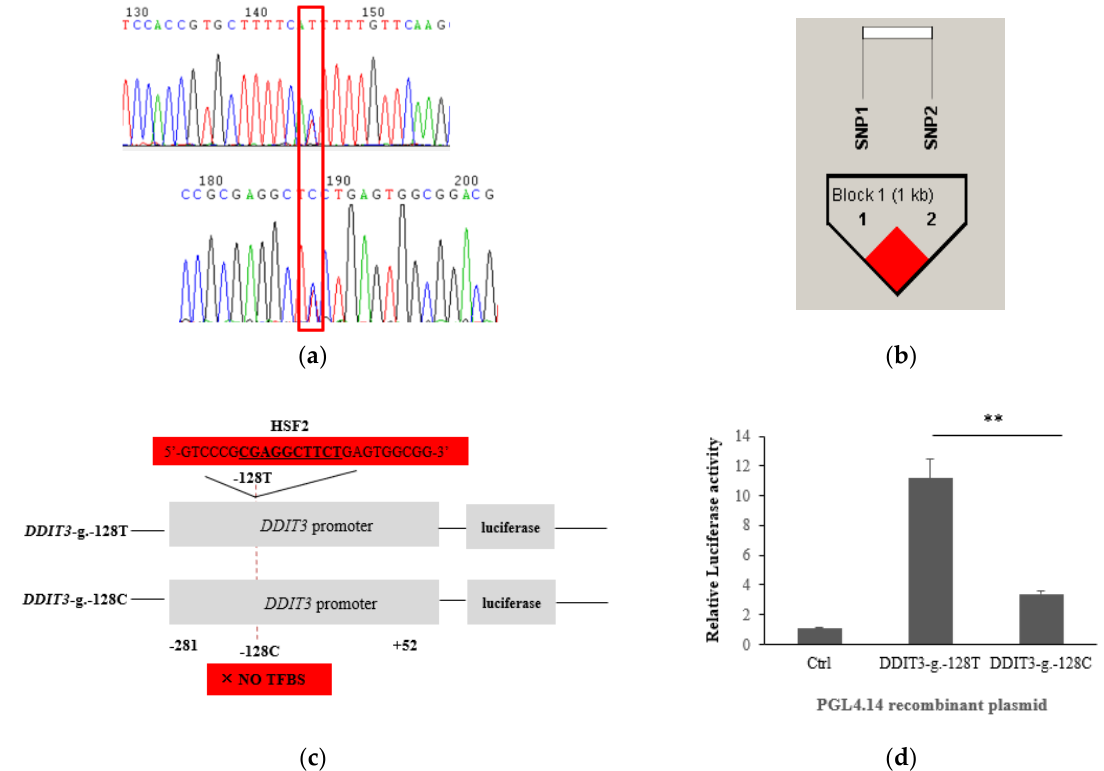
Figure 1. The variants of DDIT3 and luciferase activity analysis in HEK293 cells. Note: ( a ) The variants g.-1194 C>T and g.- 128 C>T in the 5’ regulatory regions. ( b ) The haplotype block and LD pattern formed by g.-1194 C>T and g.-128 C>T in the DDIT3 ; the darker shading indicates higher LD. The length of the block is provided in kilobases (kb), and pairwise linkage disequilibrium (D’) is given for each SNP combination. ( c ) TFBS modified from TFSEARCH software output; underlined nucleotides denote the TFBS sequences. ( d ) Luciferase activity analysis; the value was shown as the mean ± SEM. p values are from a t-test (two-tailed). ** p < 0.01.